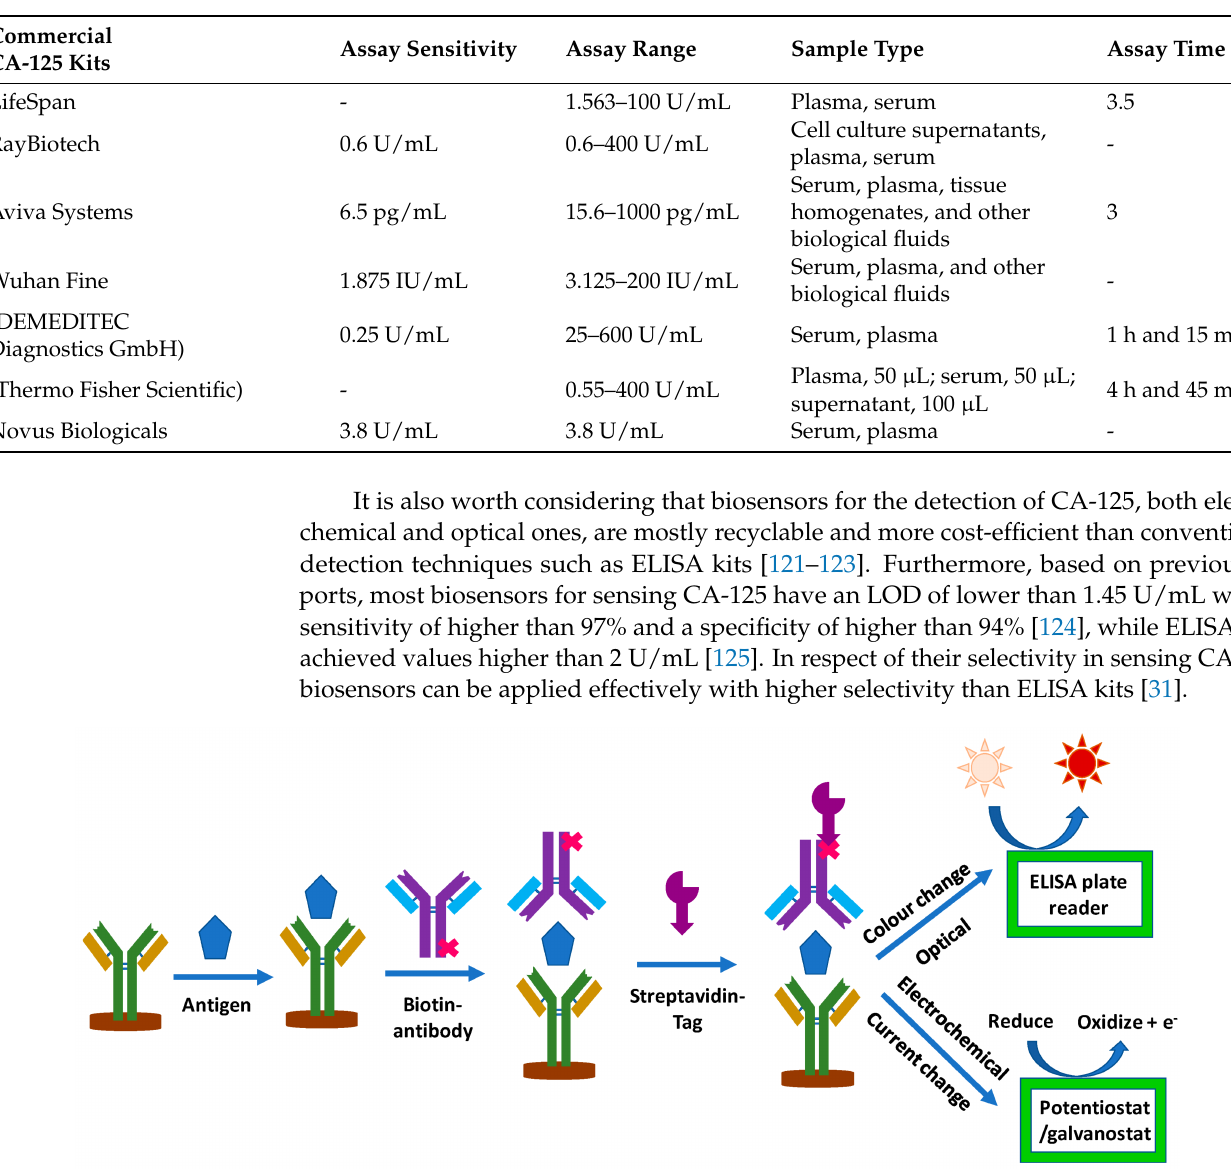
Table 5. Comparison of the performance of a range of CA-125 commercial detection kits.